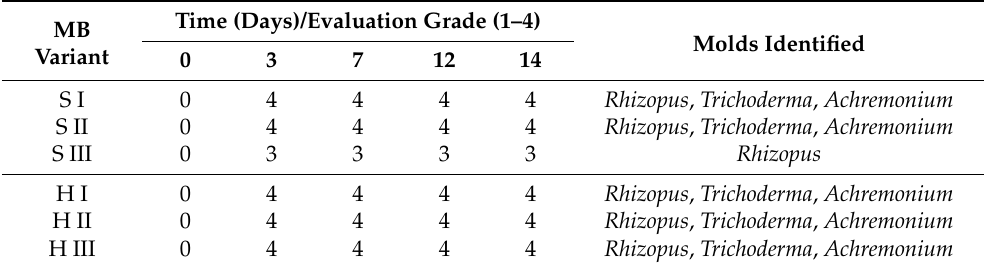
Table 6. Mold growth on mycelium biocomposites (MB) during 14 days exposure. S = sawdust; H = hemp; I, II, III = variants.